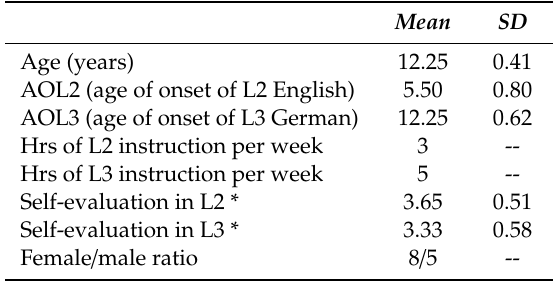
Table 1. Participant profiles.